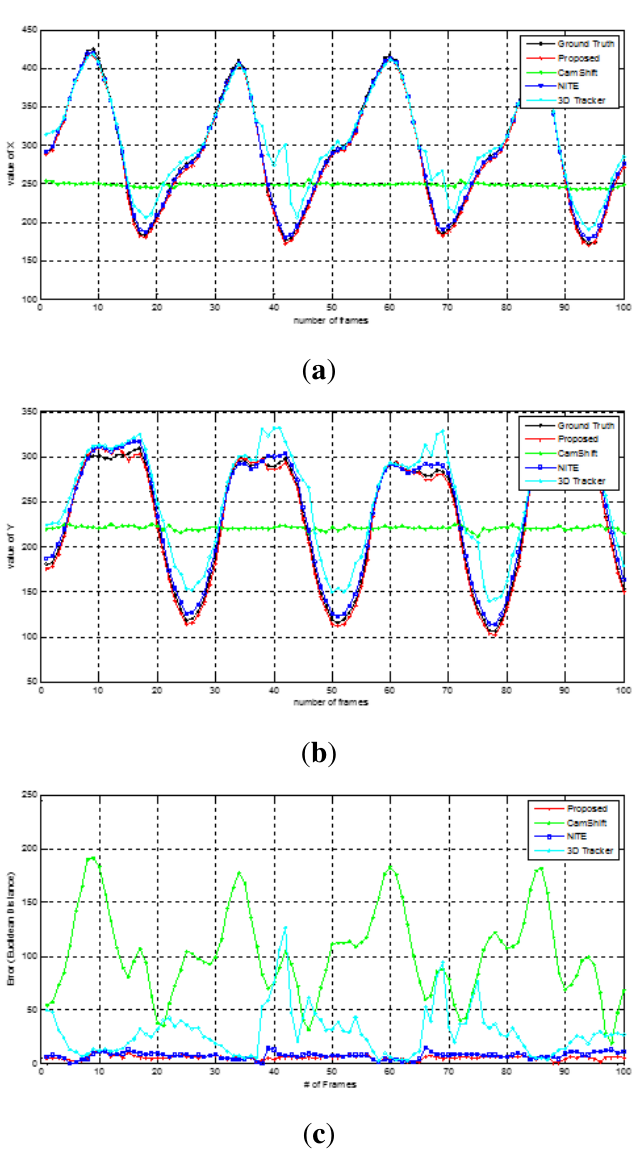
Figure 11. Comparisons of the tracking accuracy: ( a ) x-axis; ( b ) y-axis; and ( c ) RMS errors between the ground truth and the tracking position.